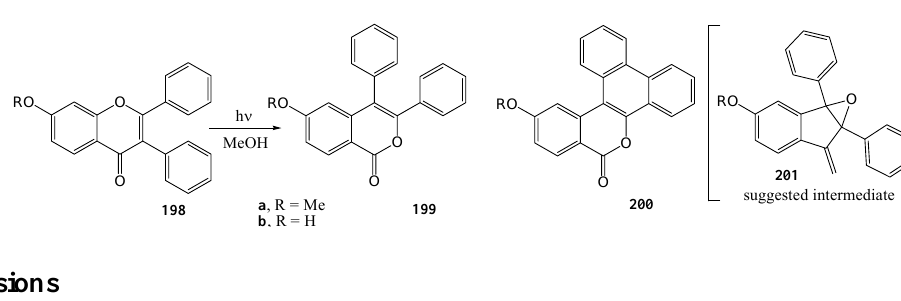
Scheme 71. Photochemistry of